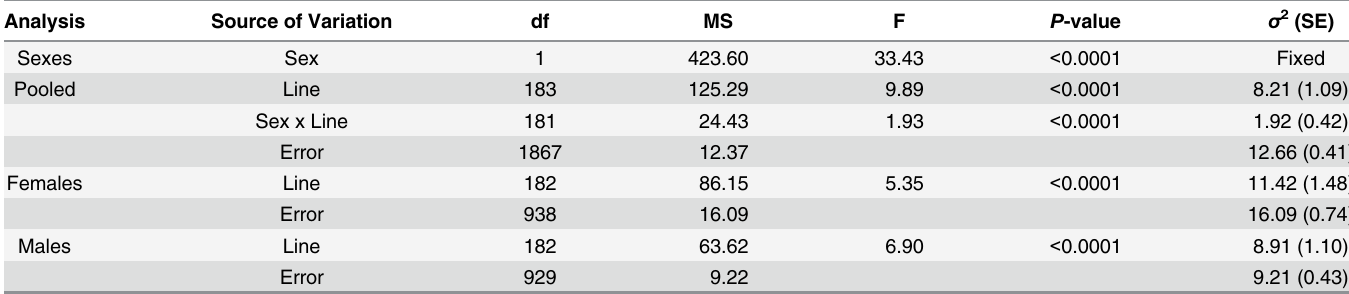
Table 1. Analyses of variance (ANOVA) of food